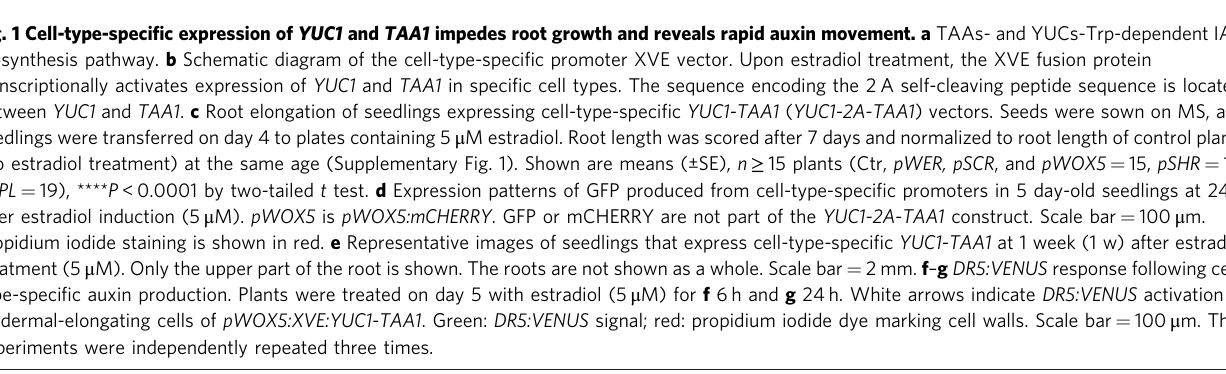
Fig. 1 Cell-type-speci fi c expression of YUC1 and TAA1 impedes root growth and reveals rapid auxin movement. a TAAs- and YUCs-Trp-dependent IAA biosynthesis pathway. b Schematic diagram of the cell-type-speci fi c promoter XVE vector. Upon estradiol treatment, the XVE fusion protein transcriptionally activates expression of YUC1 and TAA1 in speci fi c cell types. The sequence encoding the 2 A self-cleaving peptide sequence is located between YUC1 and TAA1 . c Root elongation of seedlings expressing cell-type-speci fi c YUC1-TAA1 ( YUC1-2A-TAA1 ) vectors. Seeds were sown on MS, and seedlings were transferred on day 4 to plates containing 5 μ M estradiol. Root length was scored after 7 days and normalized to root length of control plants (no estradiol treatment) at the same age (Supplementary Fig. 1). Shown are means (±SE), n ≥ 15 plants (Ctr, pWER, pSCR , and pWOX5 = 15, pSHR = 18, pAPL = 19), **** P < 0.0001 by two-tailed t test. d Expression patterns of GFP produced from cell-type-speci fi c promoters in 5 day-old seedlings at 24